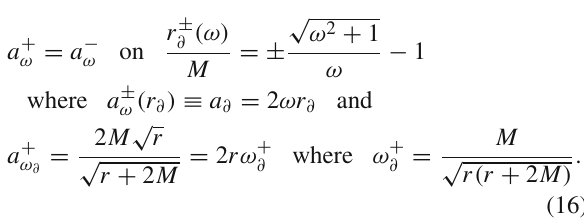
Fig. 10 Left panel: regions a ± ω > M ( NS ) and a ± ω ∈ [ 0 , M ] ( BH ) versus r / M . The ergoregion (cid:21) + (cid:9) , the NS and the BH regime are shown. Right panel: (cid:2) − a ω ≡ a + ω − a − ω = constant in the plane r − ω . The arrowsindicateincreasingvaluesof (cid:2) − a ω .Thecurve a = M and r ∂ (ω)